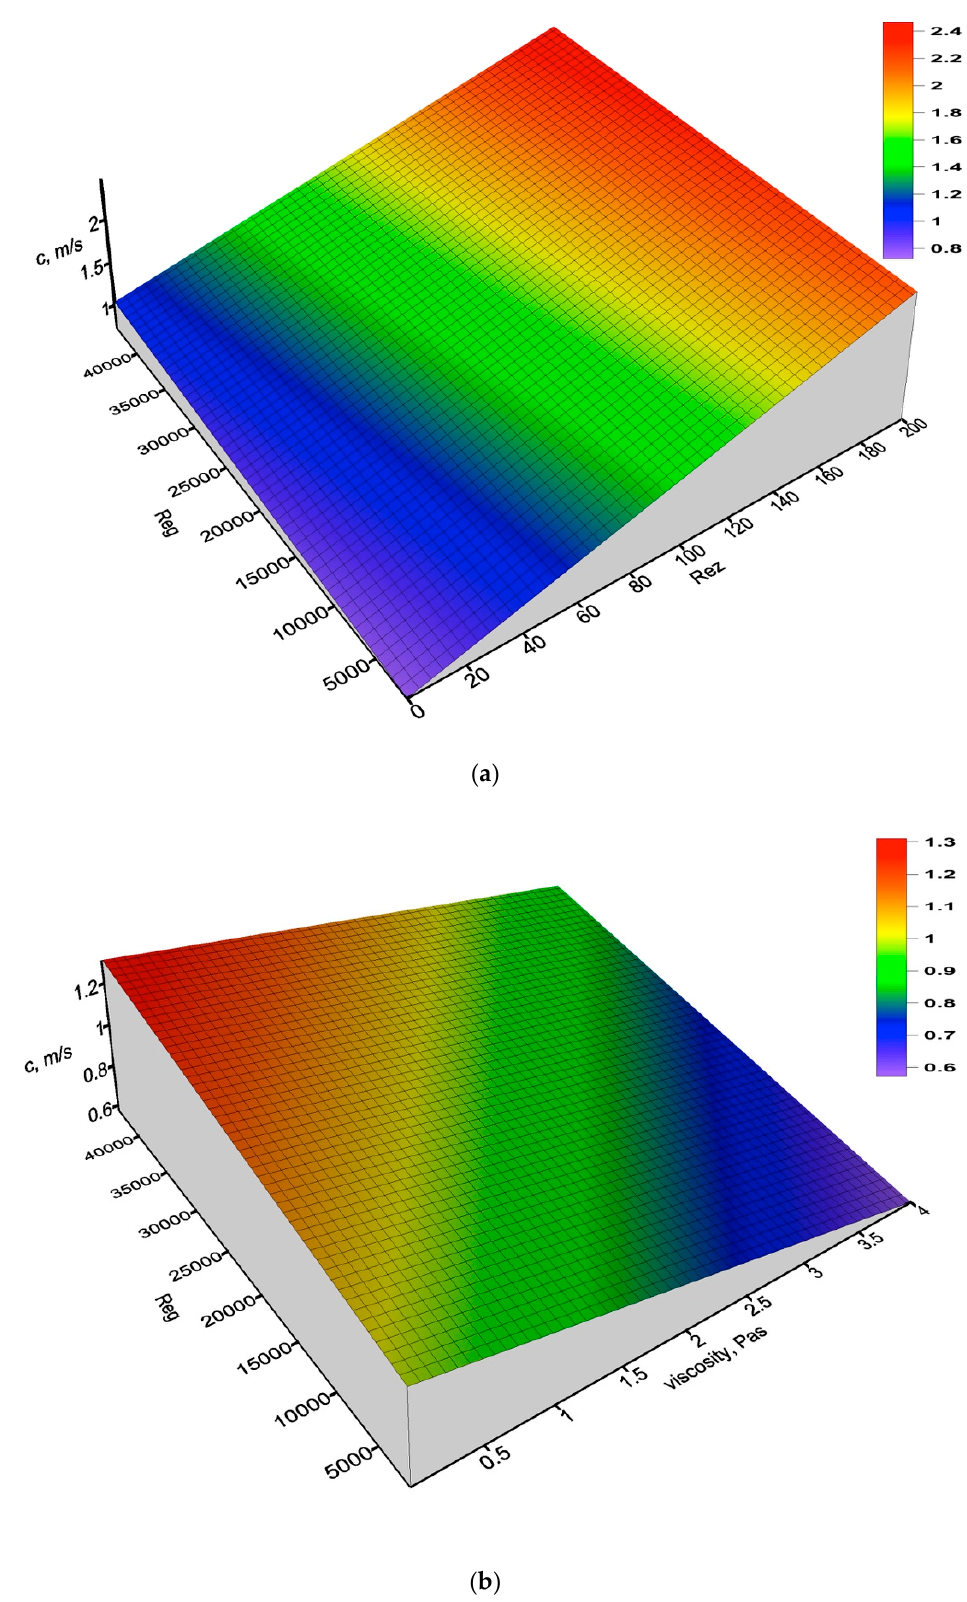
Figure 15. Results of calculations of wave velocity accompanying two-phase gas-very viscous liquid flow for relation (15). ( a ) depending on Re z value; ( b ) depending on the viscosity value.